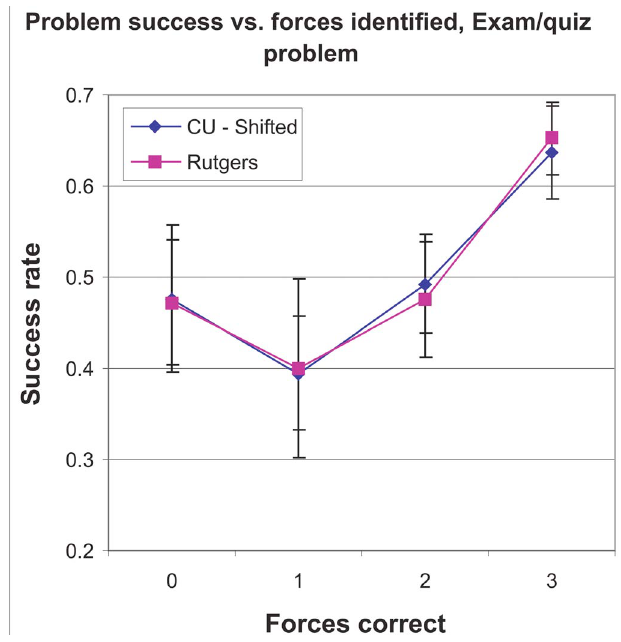
FIG. 5. (cid:1) Color (cid:2) Challenge question performance as a function of number of forces identified correctly. Note that CU scores have been shifted to account for free response vs multiple choice